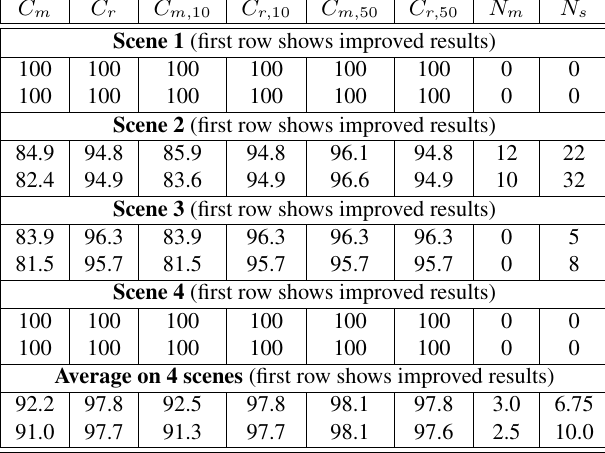
Table 2: Comparing object-based building detection results in September data sets with and without the application of the pro- posed improvement. C m = completeness and C r =